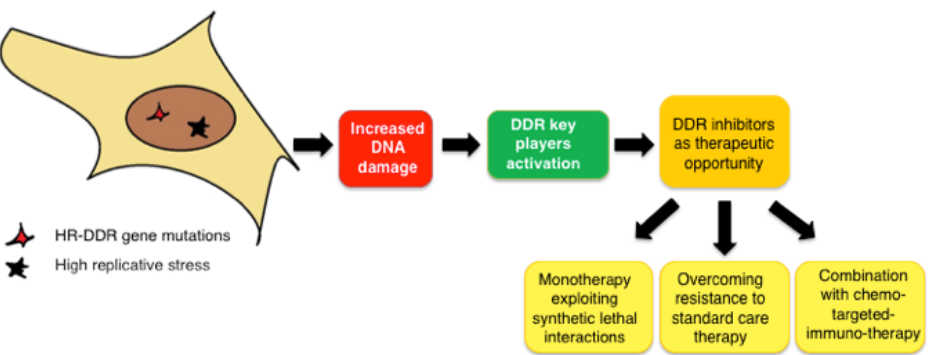
Figure 3. Schematic representation of the therapeutic advantage of using DDR inhibitors in melanoma.